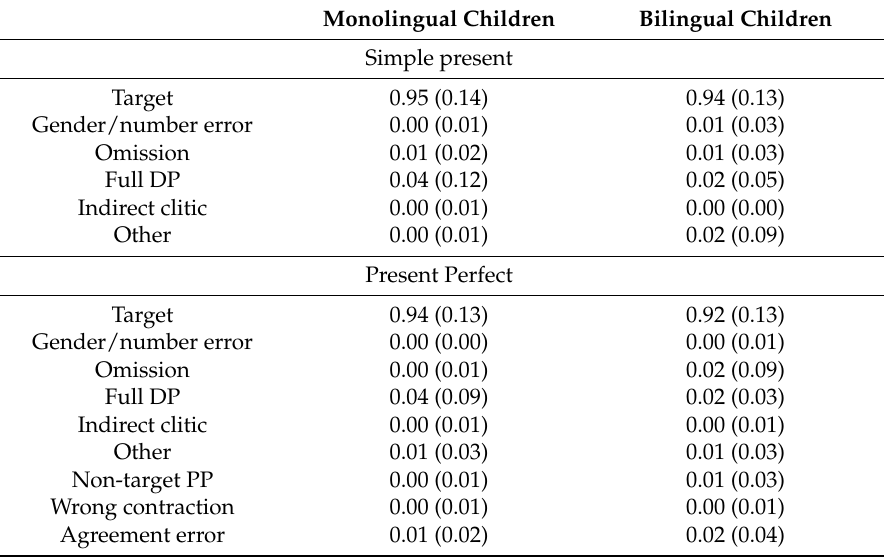
Table 3. Mean (and SDs) of responses in the clitic production task for each